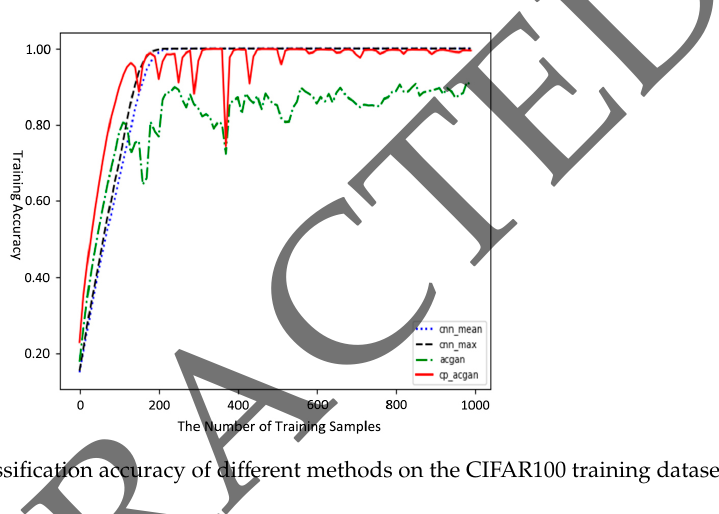
Figure 12. Average classification accuracy of different methods on the CIFAR100 training dataset.